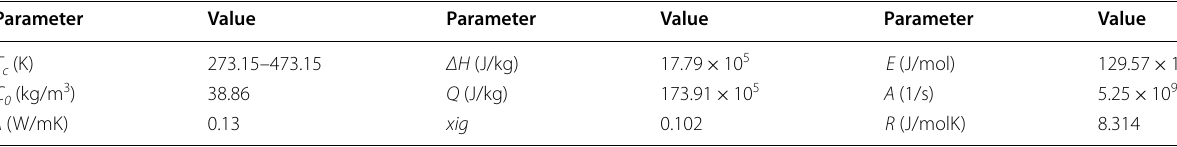
Table 5 Calculation parameters used in Frank-Kamenetskii model